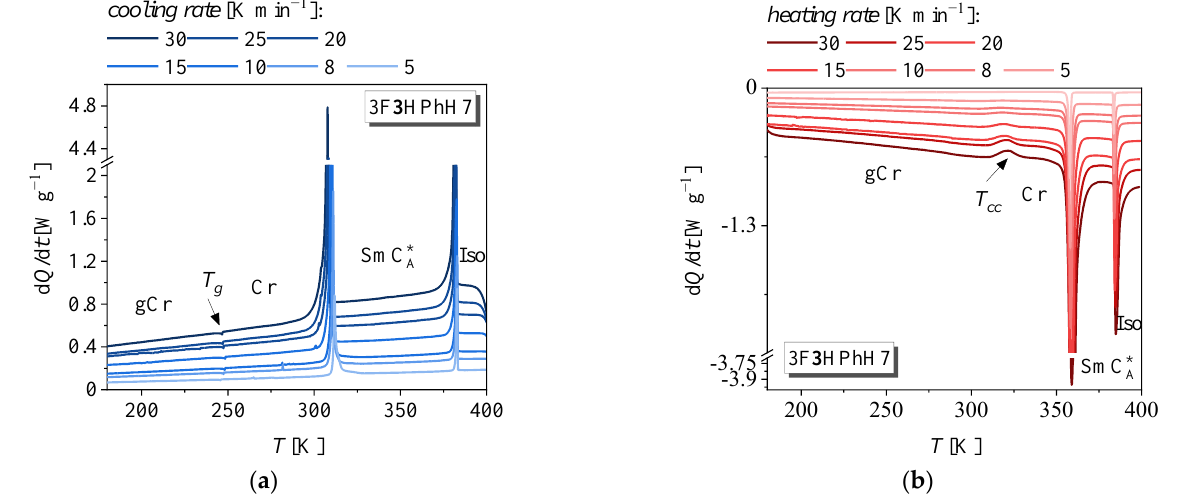
analysis, using ‘rgb’ and ‘gray-scale’ methods (Figure 3b); the procedures are described in [18]. The first method is useful when during the phase transitions, the POM textures (after previous fast cooling) belong to the glassy state of the crystal phase. The significant change in the light intensity in the range of 260–270 K may be interpreted as the softening of the gCr state. The occurrence of the local minimum on the ‘gray-scale’ curve is identified as a cold crystallization process. The melting of the Cr phase (the exampled texture is collected at 314 K) is associated with the decrease in the light intensity (with the texture at 358 K). The textures collected at 361 K and 375 K belong to the SmC A * phase. The observed change in colour is caused by the continuous ordering of molecules in the smectic layers. The changes visible in the plots of the thermooptical analysis correlate well with the anomalies on the DSC curves. Comparing both ‘rgb’ and ‘gray-scale’ algorithms, one can see that the ‘rgb’ method provides much more sensitivity than the ‘gray-scale’ approach.